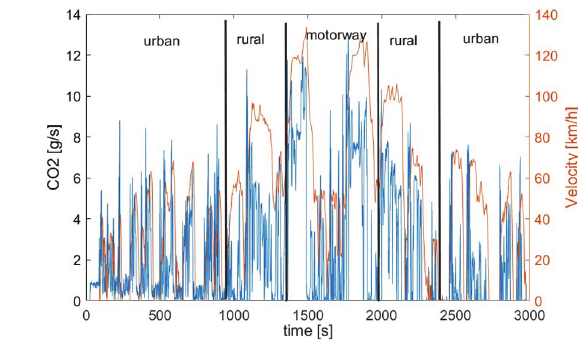
Fig, 3. Emission intensity of CO 2 for Euro 3 petrol fuelled vehicle